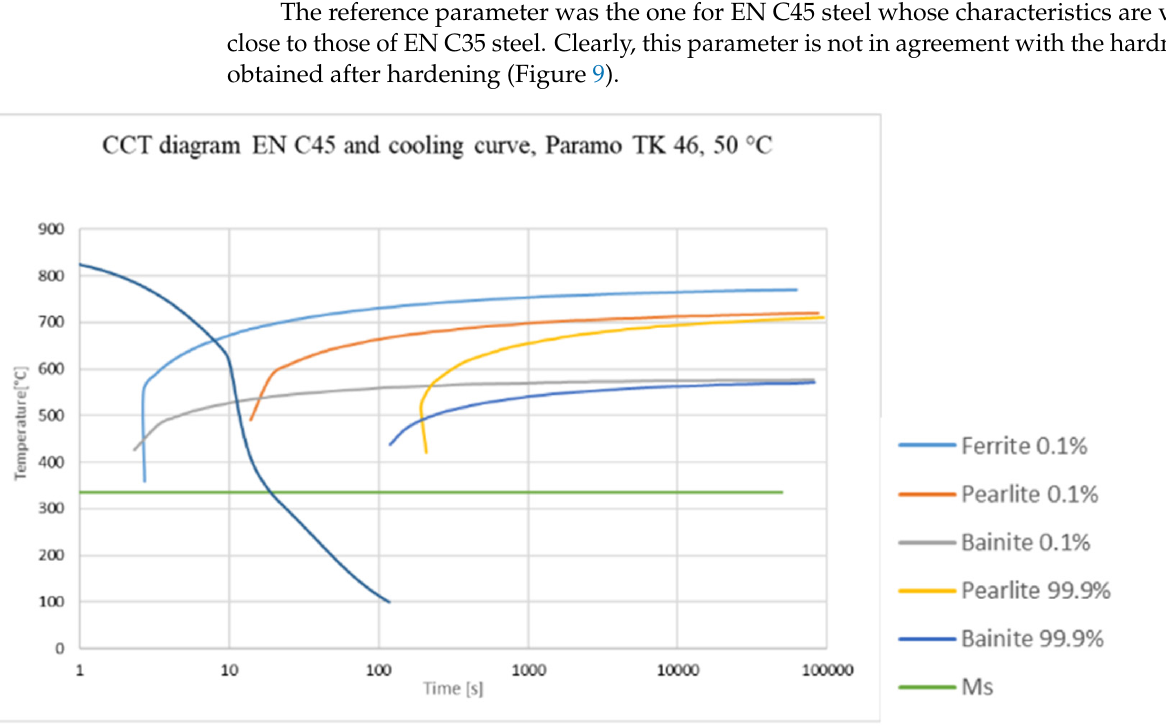
Figure 9. Correlation between hardness and V-value. 3. Effect of Water Content on Cooling Efficiency of Selected Oils Water content in quenching oil is one of the most frequently-discussed issue in the day-to-day operation of a hardening plant. In our experiment, the following amounts of water in oil were considered: 0%, 0.01%, 0.1%, 0.5% and 1% (Figure 10). The effect of water content on temperature-time and temperature-cooling curves was measured in Houghto Quench C120 oil. These curves were measured for water contents of 0%, 0.01%, 0.1%, 0.5% and 1%. For safety reasons, the measurement was not carried out for any water content above 1%. In line with ISO 9950, the temperature during measurement was 40 °C. The measured data only reveal a minimum impact of higher water levels on the stable vapor blanket stage. The CRmax for this oil decreases slightly with changes in water content.